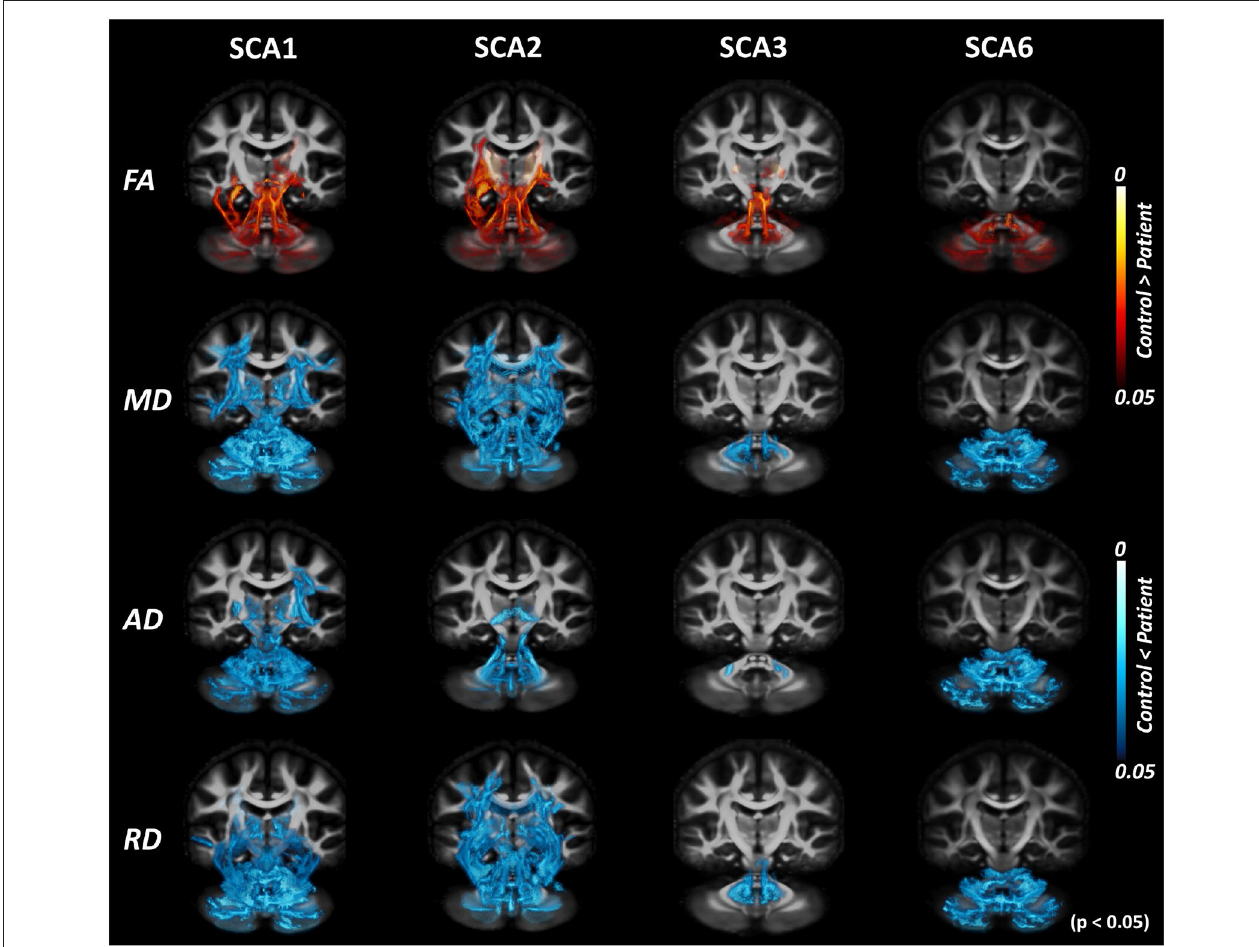
FIGURE 4 | Tract-based spatial statistics (TBSS) analysis with DTI-TK spatial normalization and FA threshold of 0.1. TBSS analysis with lowered FA threshold (from 0.2 to 0.1) shows more areas of difference between patients with SCAs and healthy controls. The effect of the choice of threshold is most prominent for SCA6.